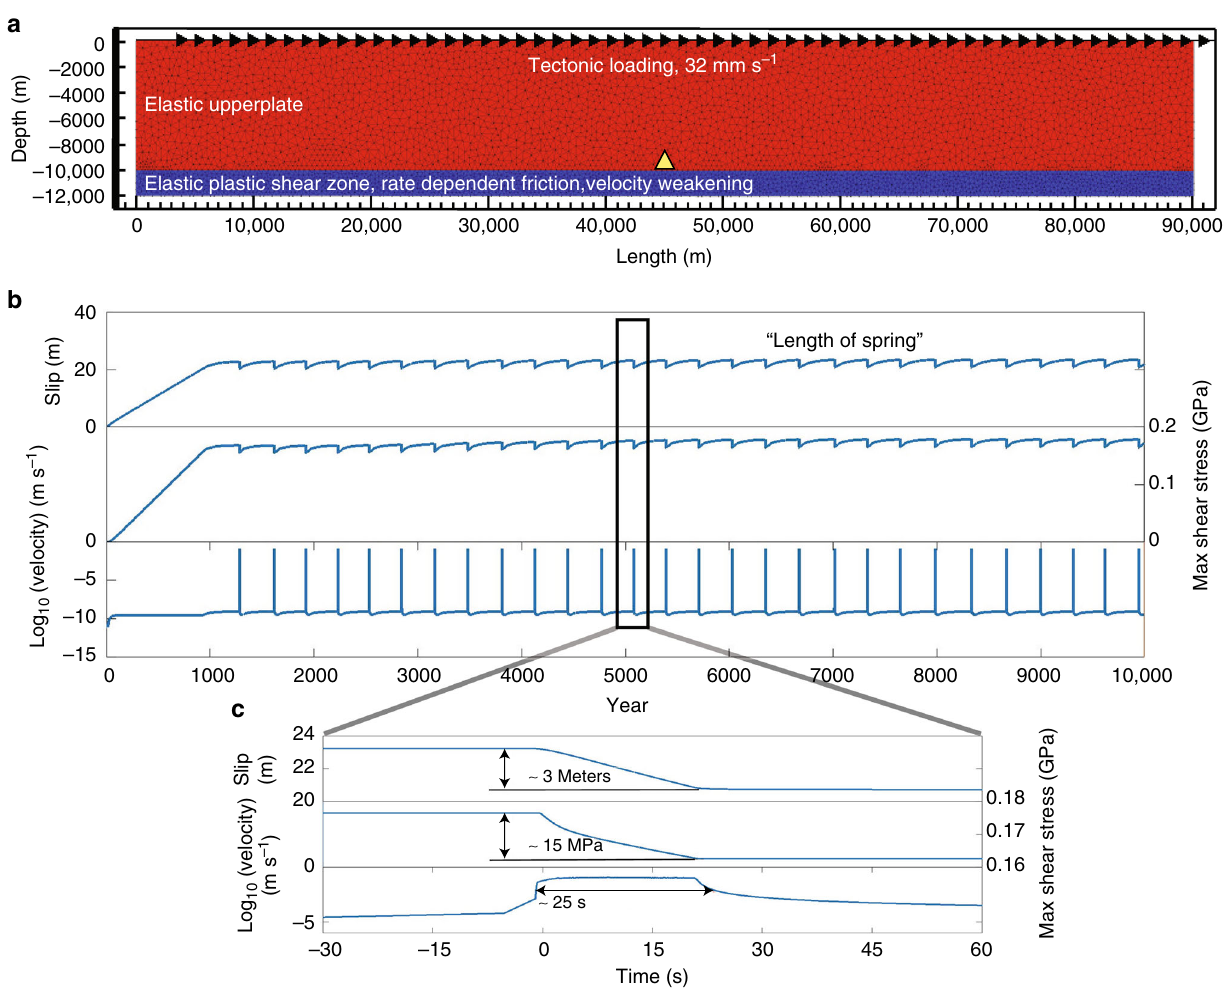
Fig. 1 A single spring slider experiment in tectonic scale. a Model setup for a 90 km fault length. a − b = − 0.004. Yellow triangle marks the element where the measurements are recorded. b Slip, maximum shear stress, and velocity are plotted over time. We stop the simulation at 10,000 year. c Zoom-in. The event has about 3 meter of co-seismic slip and 15 MPa of stress drop. The peak slip velocity reaches to 0.1 m s − 1 , and it lasts for about 25